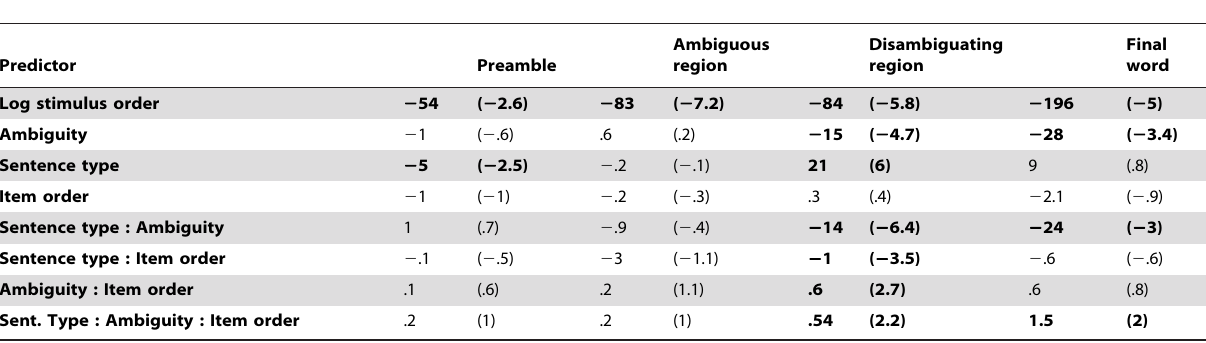
Table 1. Summary of model results at each sentence region in Experiment